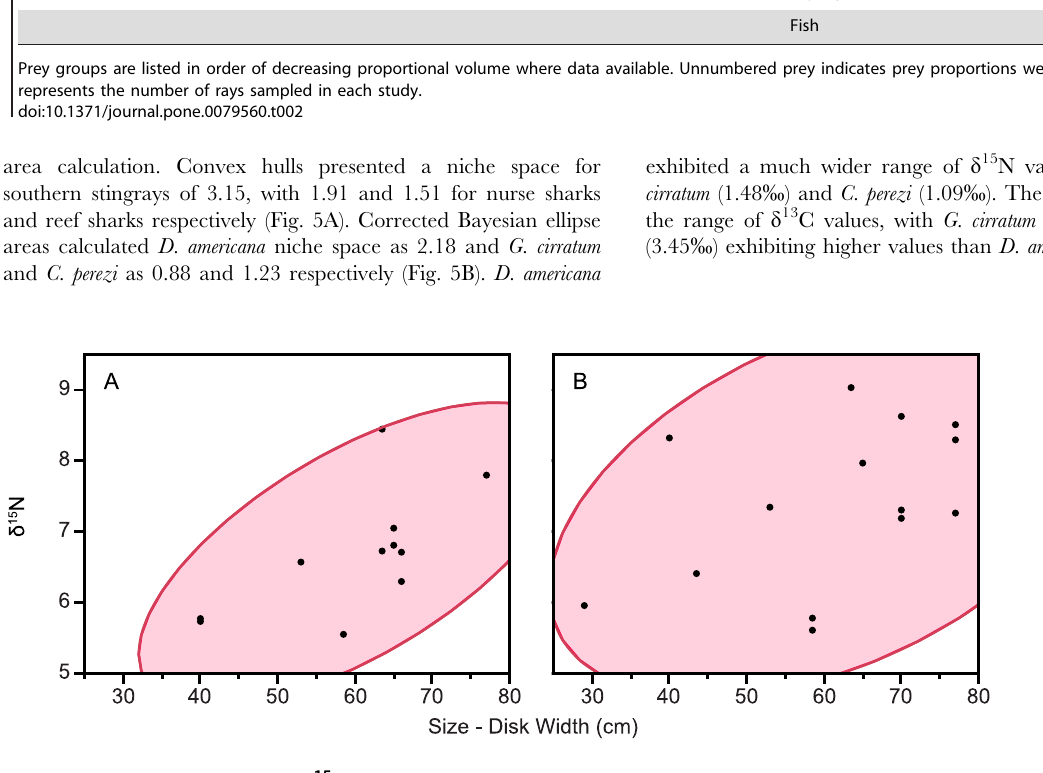
Figure 4. Relationship between d 15 N values and individual size (disk width) for D.americana skin (A) and muscle (B). Red shaded areas represent 95% bivariate normal confidence ellipses for correlative relationships (A) Spearman’s r(8)=0.75 P , 0.034 (B) Spearman’s r(11)=0.47, P=0.15. doi:10.1371/journal.pone.0079560.g004 PLOS ONE |